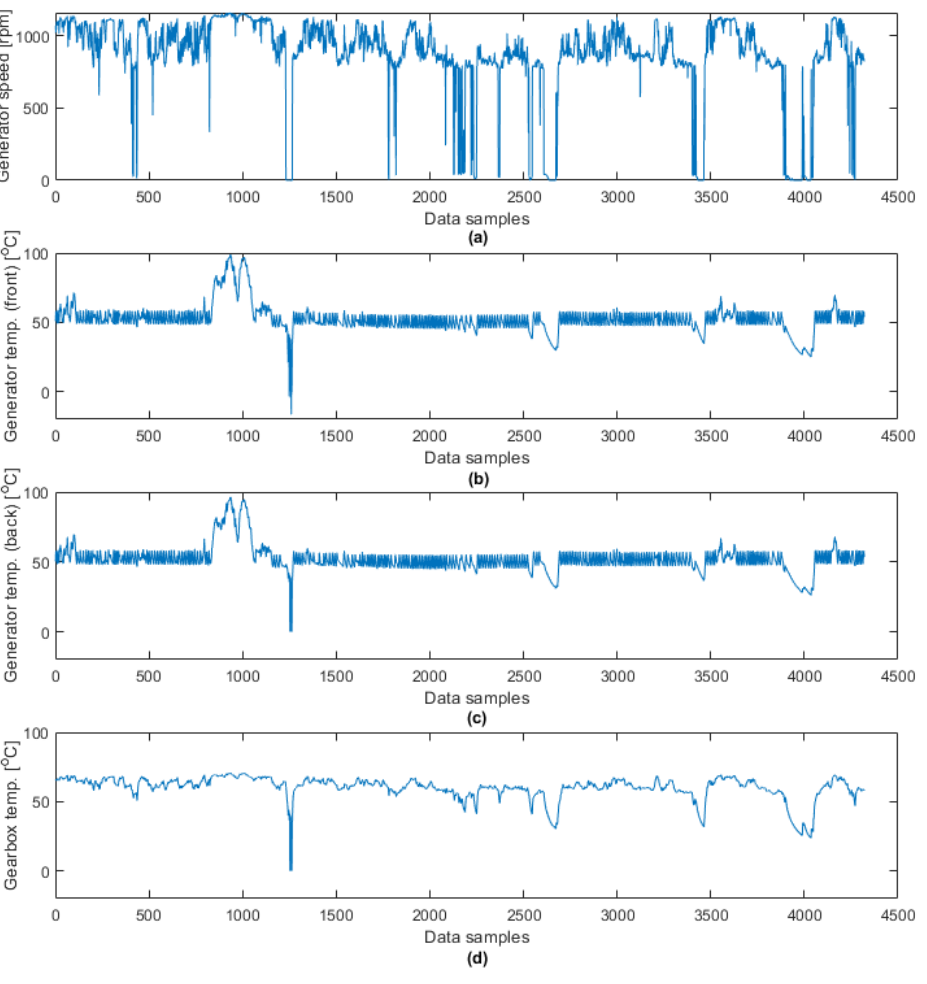
Figure 5. SCADA data set used in the case study: ( a ) generator speed; ( b ) generator bearing temperature (front); ( c ) generator bearing temperature (back); ( d ) gearbox bearing temperature.